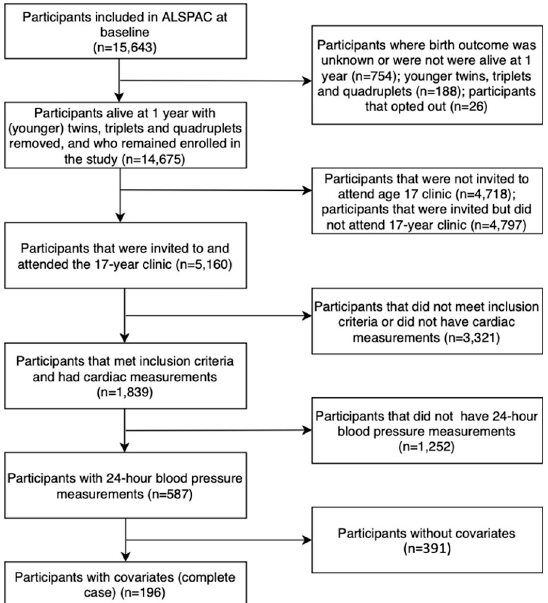
Fig 1. A STROBE diagram detailing how the study cohort was selected from the baseline Avon Longitudinal Study of Parents And Children (ALSPAC) participants.